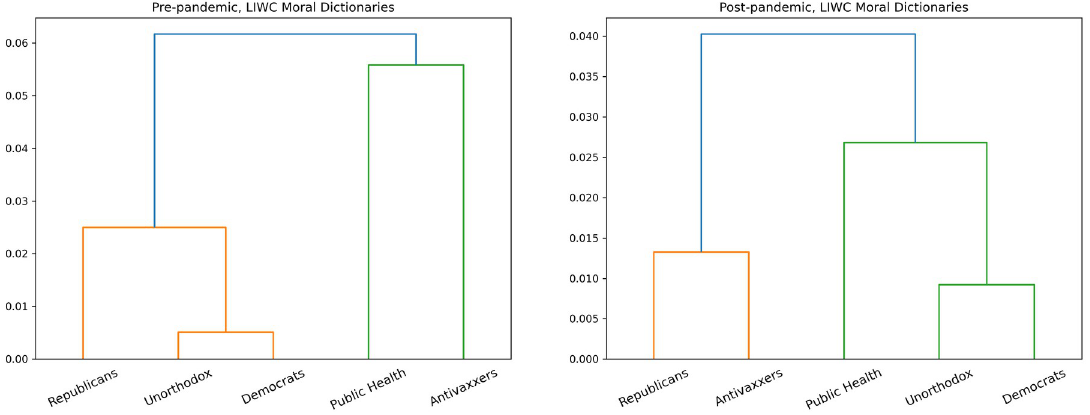
Fig 7. Dendrogram for custom MFT virtue dictionaries.